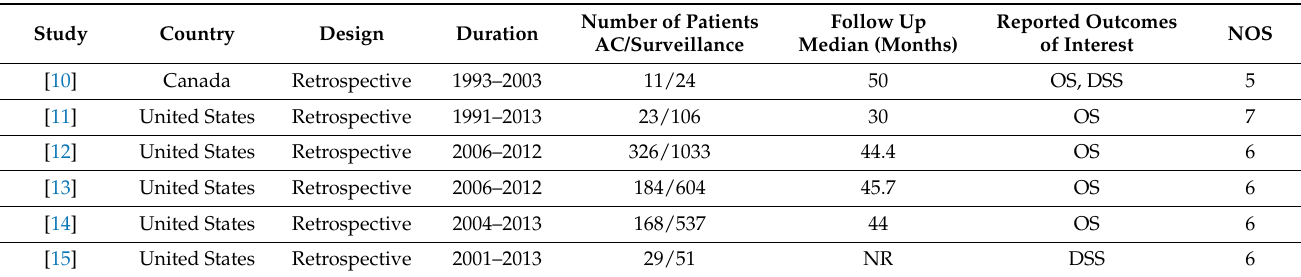
Table 1. Baseline characteristics of the included